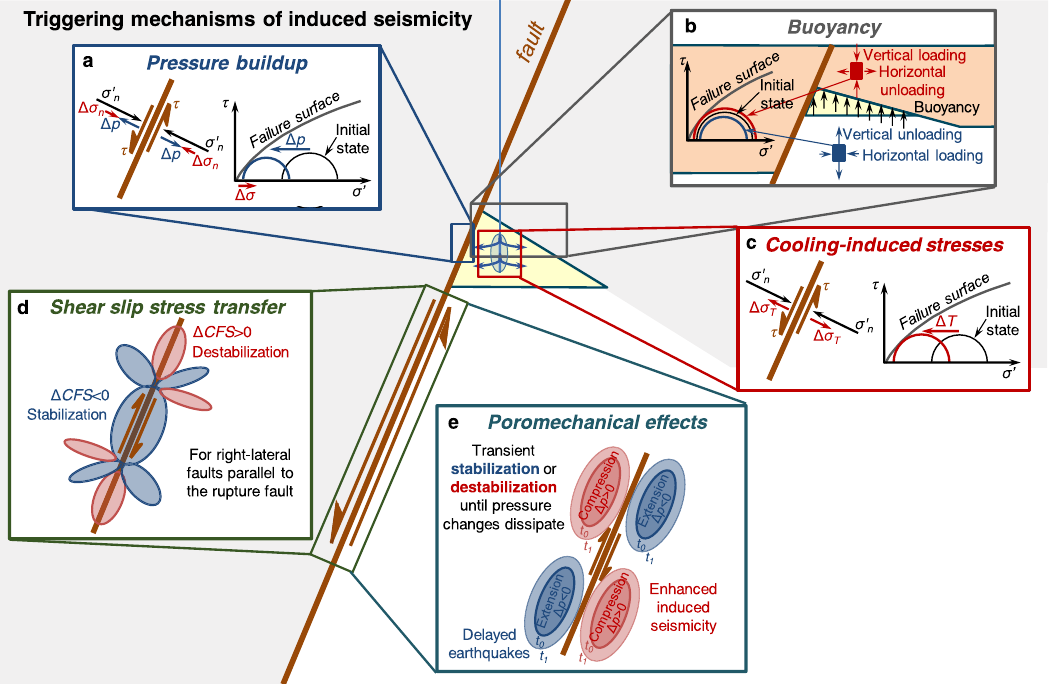
Fig. 1 Potential triggering mechanisms of induced seismicity in geo-energy applications. a Pore pressure induced by fl uid injection reduces the effective stress, approaching failure conditions; pore pressure changes induce compressive poroelastic stress that alters the initial stress state; b if the injected gas is buoyant, buoyancy causes a stress redistribution around the reservoir that may destabilize surrounding faults; c the injected fl uid generally reaches the reservoir at a cooler temperature than the rock, leading to a cooling-induced stress reduction that brings the stress state closer to failure conditions; d seismic and aseismic slip induce a static stress transfer that stabilizes regions around the slipped area and destabilize others; e slip deforms the rock surrounding the slipped area, compressing and extending the rock ahead and behind the slip, respectively, which induces transient undrained pore pressure changes that tend to destabilize and stabilize, respectively,